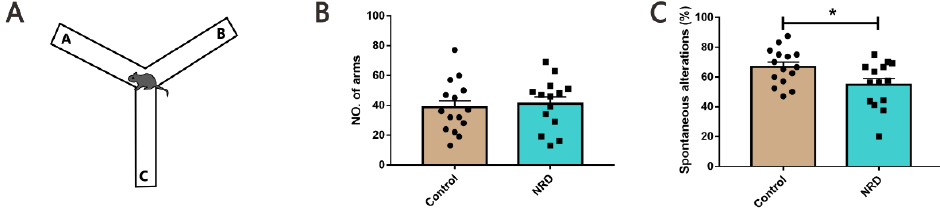
Y-maze working memory task. ( B ) The number of entries in all arm of the Y maze. ( C ) Spatial memory measured as alternation percentages in the Y maze. * p < 0.05 as determined by unpaired Student’s t -test. Data are expressed as the means ± SEMs. n (control) = 15, n (NRD) =